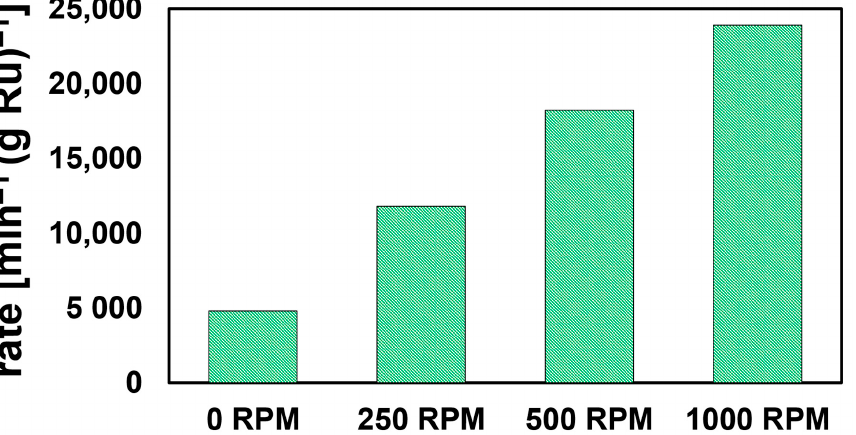
Figure 3. Ru mass-normalized pseudo-first-order kinetics plotted for the reduction of 4NP using NaBH 4 -pretreated Ru 50 @Al 2 O 3 at different stir rates ( rpm = revolutions per minute